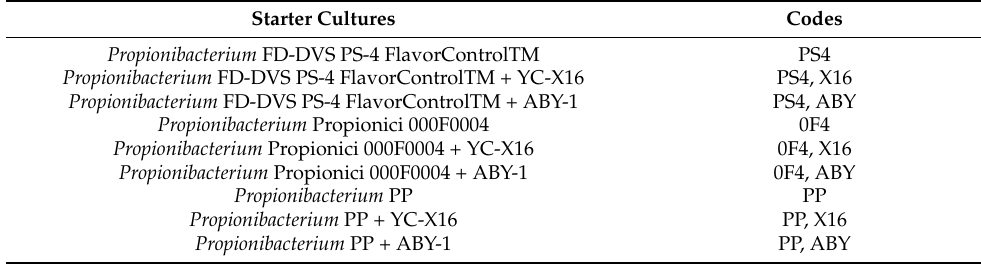
Table 1. Different combination of the addition of starter cultures used in the fermentation of rice-based